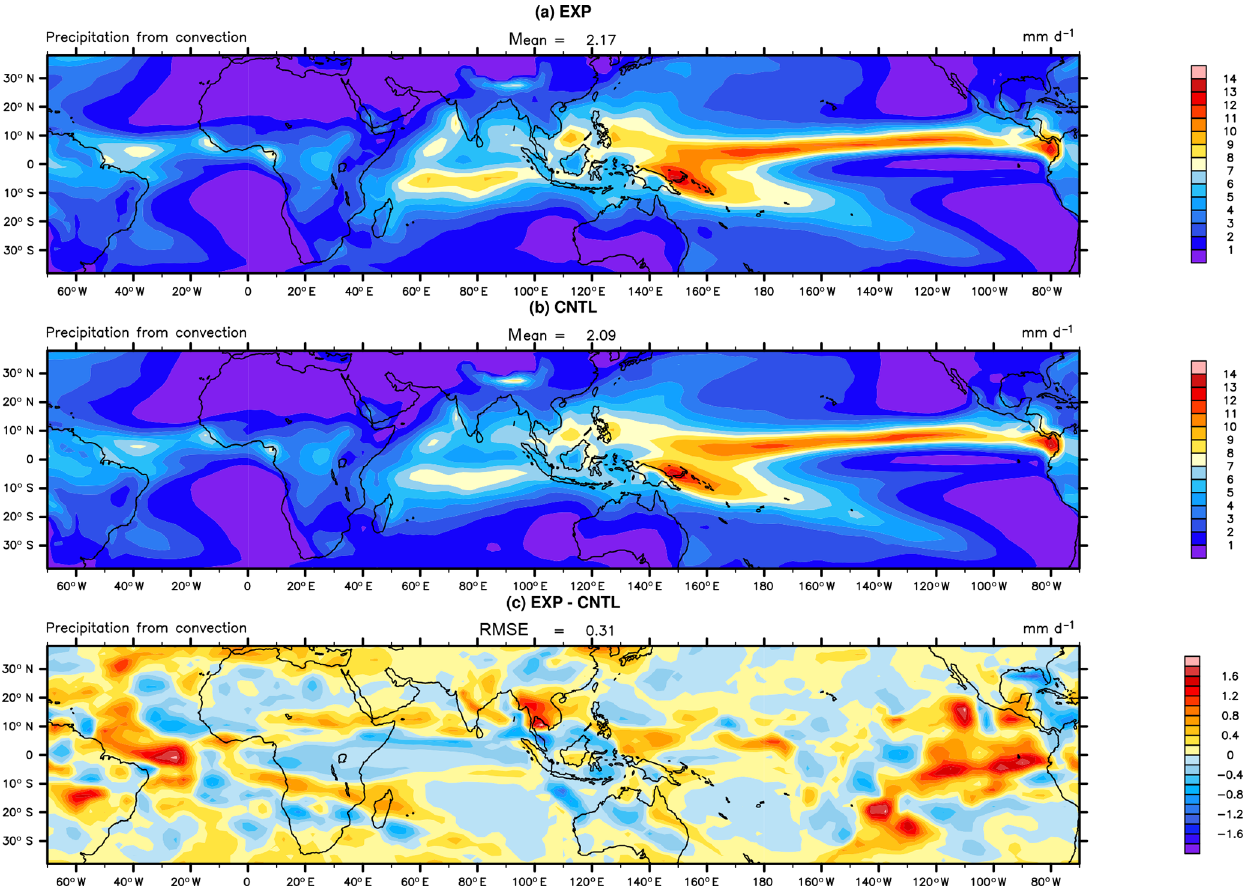
Figure 9. The spatial distribution of convective precipitation over the tropics of EXP (a) , CNTL (b) , and EXP–CNTL (c) .